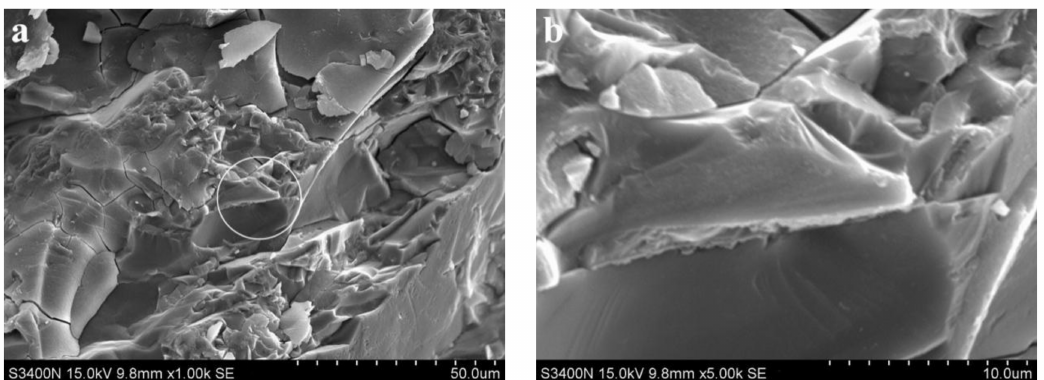
Figure 9. SEM images of alkali slag cement mortar with hydration ages of 28 d. ( a ) × 1.00 k, ( b ) × 5.00